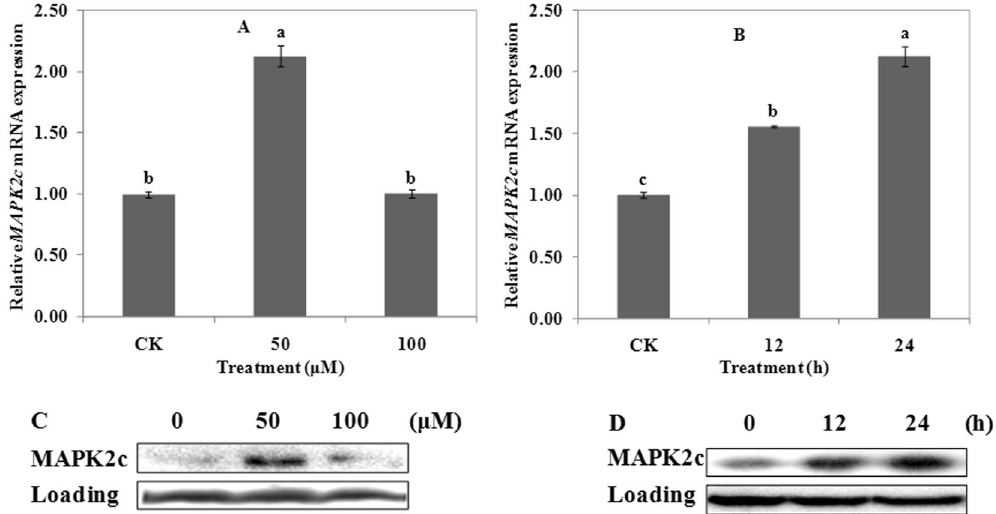
Figure 6. Expression and western blot detection of MAPK2c in wheat. Real time quantitative RT-PCR and western blot were used to assess MAPK2c expression in root apexes (0–20 mm) of wheat lines ET8. Four-day- old wheat seedlings were exposed to 0.5 mM CaCl 2 solution (pH 4.5) containing 0 (CK), 50 or 100 μ M AlCl 3 for 24 h ( A and C ). Four-day-old wheat seedlings were exposed to 0.5 mM CaCl 2 solution (pH 4.5) containing 0 or 50 μ M AlCl 3 for 0 (CK), 12 and 24 h ( B and D ). Data are means ± SD (n = 3). Small letter differences in the same figure mean significant difference at P <